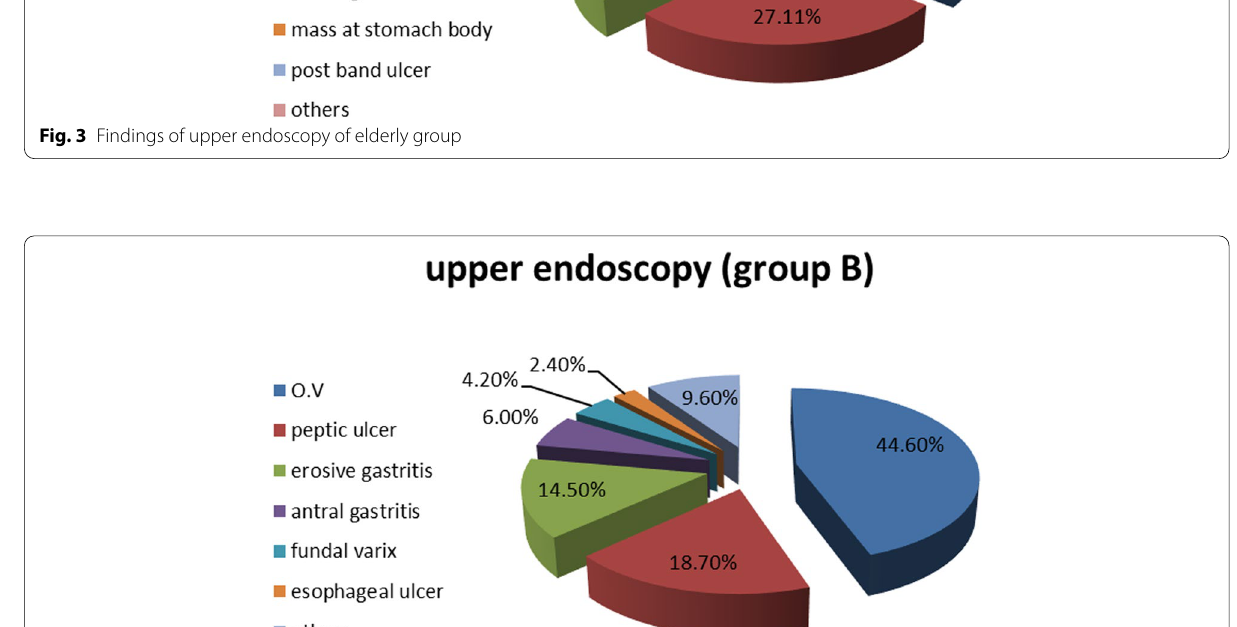
Fig. 4 Findings of upper endoscopy of young